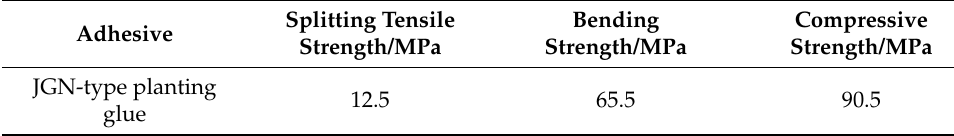
Table 3. Mechanical properties of cement indices of adhesive.